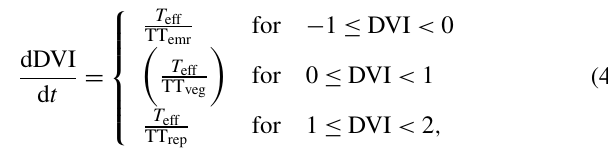
Table 2. JULES plant functional type (PFT) parameters and values modified for use in this study. We include only the values that have been changed or are new in JULES since Osborne et al. (2015). Parameter JULES nota- Description (units) Winter wheat Sorghum Spring wheat Rice tion Lower temperature for photosynthesis ( ◦ C). Upper temperature for photosynthesis ( ◦ C). Scale factor relating V cmax with leaf ni- trogen concentration. Top leaf nitrogen concentration (kgN ( kgC ) − 1 . fsmc method nential root distribution with depth. When equal to 1, the soil moisture